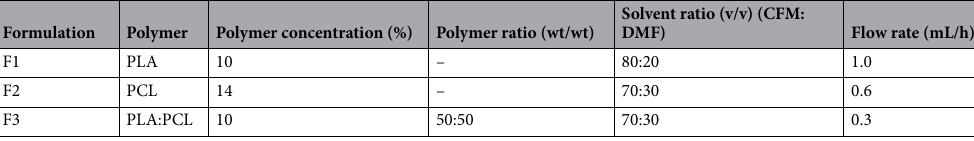
Table 1. Composition of different